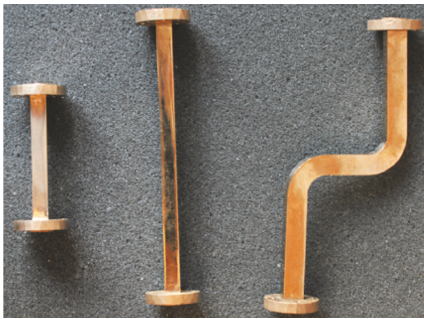
Figure 4: 3D printed waveguides, from left: 50mm straight waveguide, 100mm straight waveguide, and bend